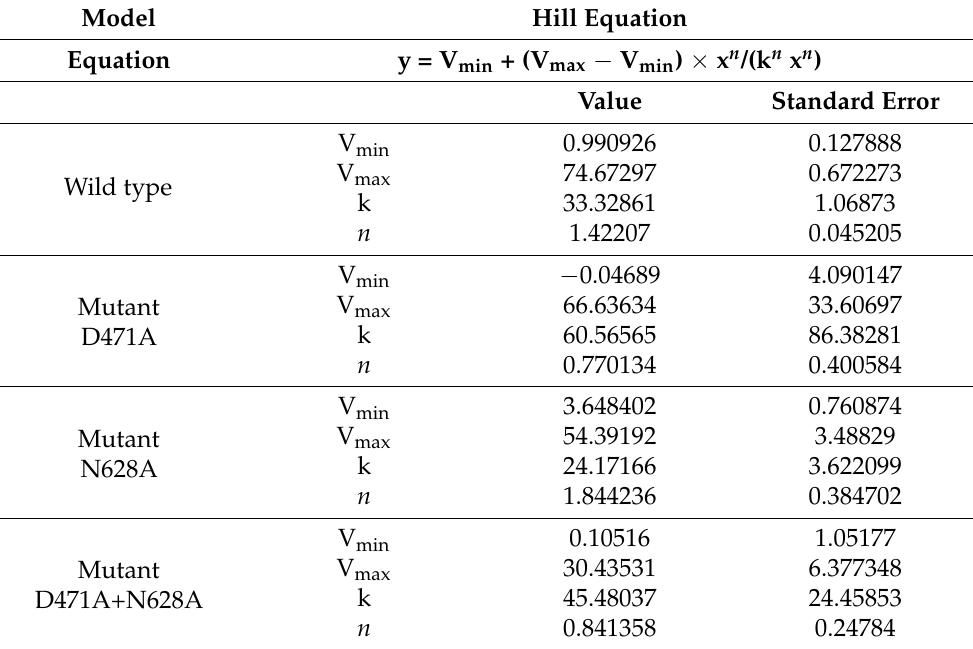
Figure 5. The binding pocket and docking results of naringin and TRPV1: ( A ) the binding pocket in the TRPV1 region of the extracellular domain membrane pocket side. ( B ) Two-dimensional schematic presentation of the predicted binding mode of naringin in the ligand-binding pocket. The ligands and important residues are shown. ( C , D ) Computational simulated binding interaction of ligand and residues in wild-type and mutants. The replaced mutants showed changes in interaction activities at varying degrees. ( C ) Interaction between naringin and wild-type TRPV1. ( D ) Interaction between naringin and mutant-type TRPV1. Table 1. Inhibitory effect of naringin on wild-type and mutant TRPV1